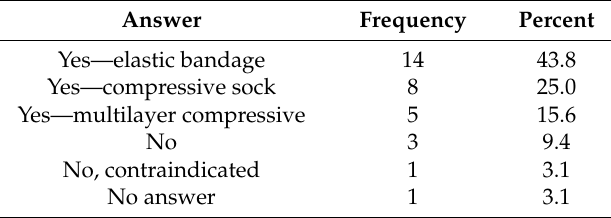
Table 3. Overview of participants use of compression